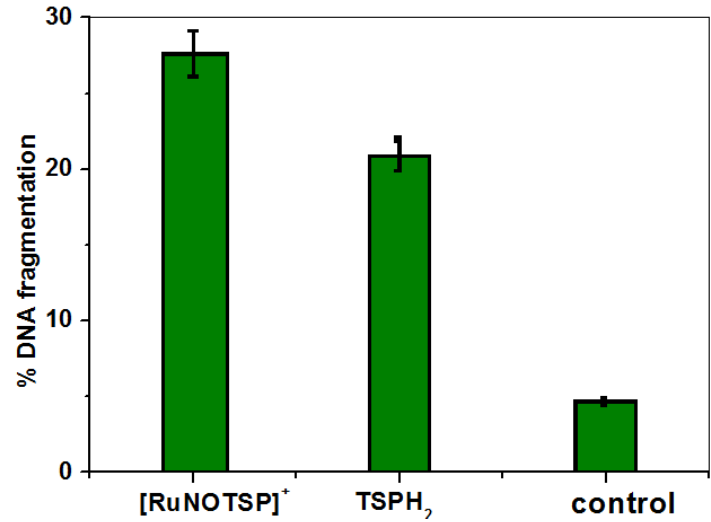
Figure 12. Plots of fragmented DNA quanti fi cation.